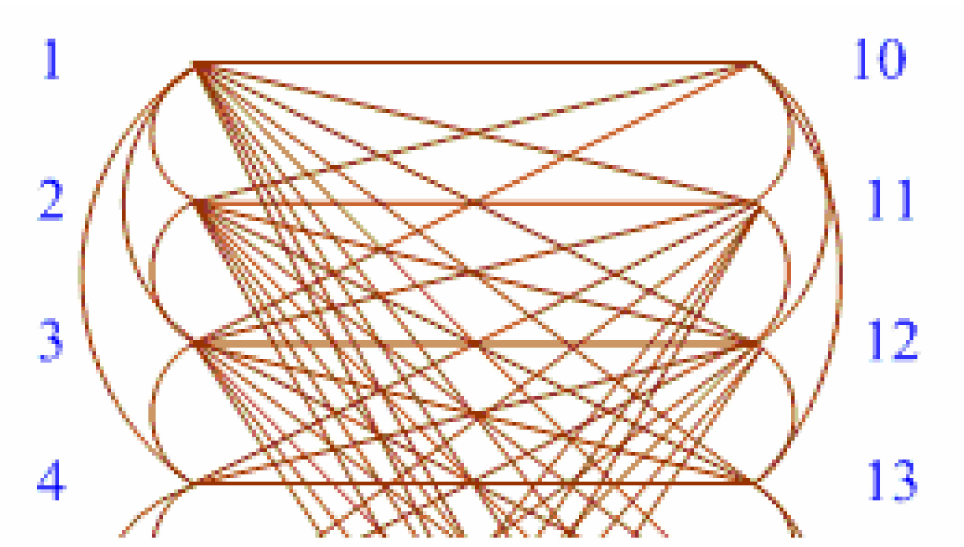
Figure 8. A fragment of the graph of a three-circuit power line: the numbers indicate the numbers of